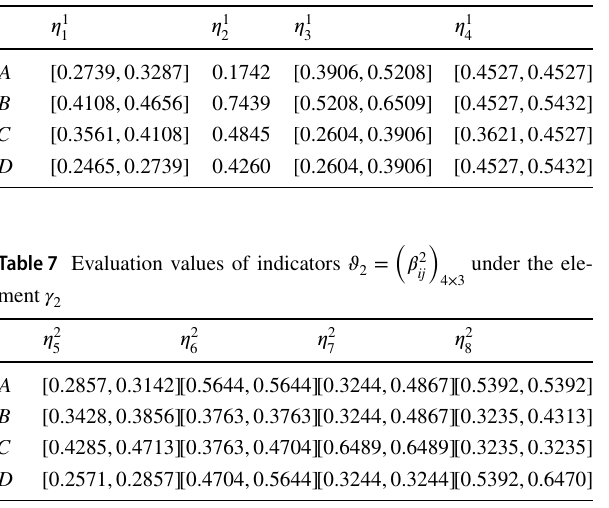
Table 6 Evaluation values of indicators 𝜗 1 = ment 𝛾 1